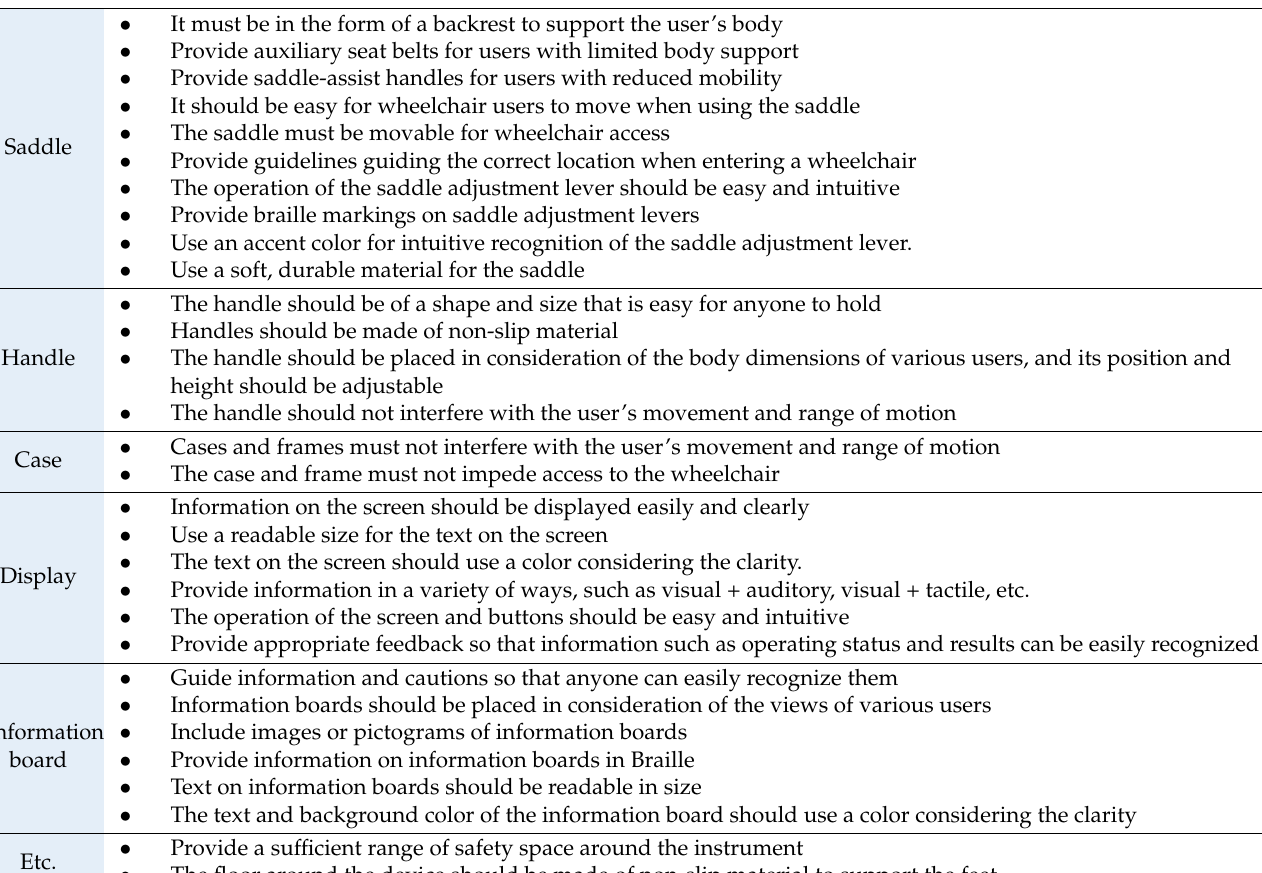
Figure 16. Second design concept of the arm ergometer applying UD . Table 10. Arm ergometer guidelines with UD applied .